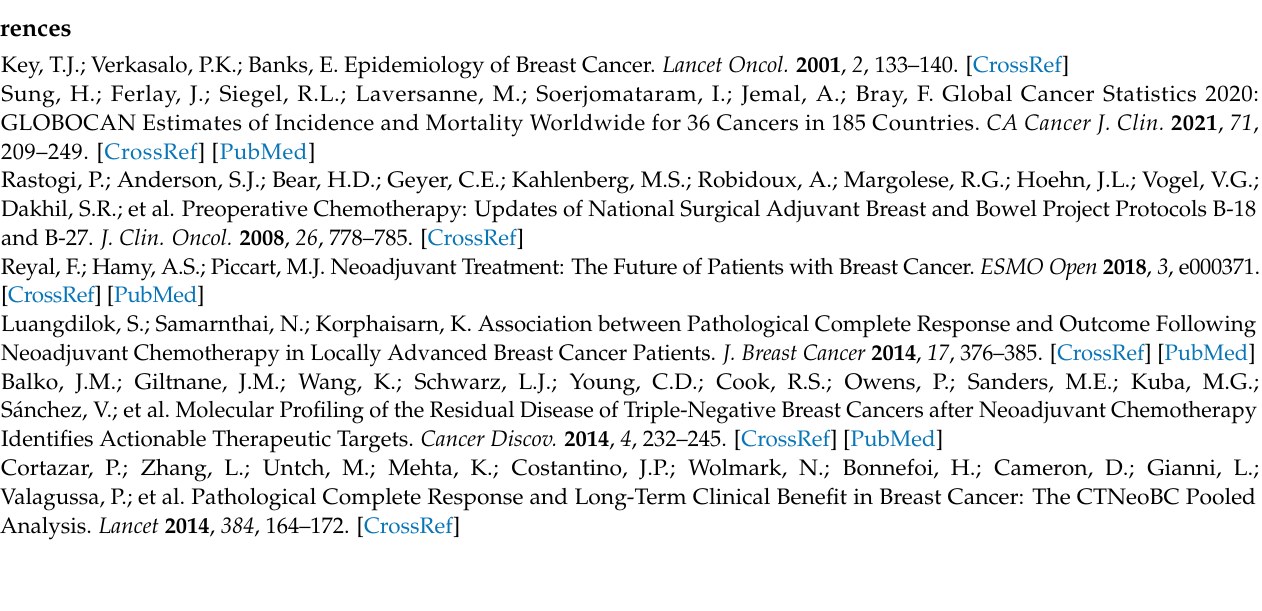
seasons, Figure S5: Associations between post-NAC TILs and month in whole population, and after stratification by breast cancer subtype, Figure S6: Distant relapse-free survival curves by season at BC diagnosis, Figure S7: Forest plot—Hazard Ratio RFS (Univariate analysis). Survival impact of Table S1: Patients’ characteristics according to season in each tumor subtype, Table S2: Association of season with pCR after univariate analysis in the whole population, Table S3: Literature